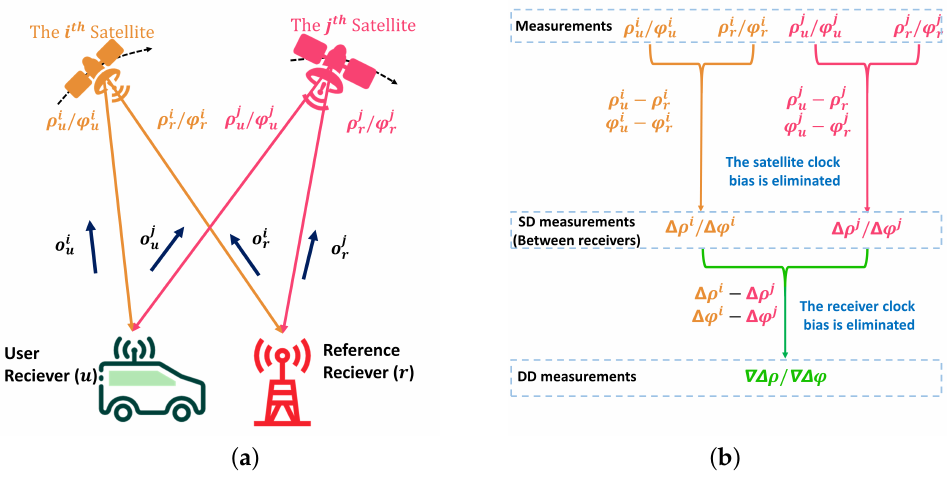
Figure 1. SD measurements and DD measurements. ( a ) Two receivers track the signals of two satellites. ( b ) Steps to calculate SD measurements and DD